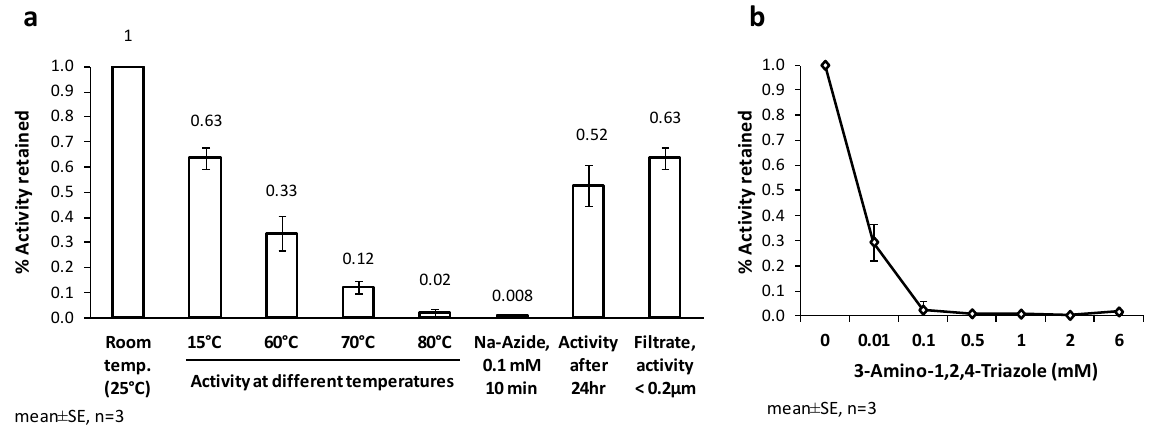
Figure 6. Basic biochemical characterization of the coral-released antioxidant activity. The effect of temperature (15, 60, 70, and 80 ◦ C), the heme-enzyme inhibitor (0.1mM Na Azide), filtration (0.2µm), and storage (24h) on antioxidant activity from coral incubation water (a) . The effect of increasing concentrations of the catalase inhibitor 3-Amino-1,2,4-Triazole (0.01–6mM) on coral-released antioxidant activity (b) . The antioxidant activity of the treated water samples ( n = 3; mean ± SE) is presented as the percentage of the non-treated samples ( n =